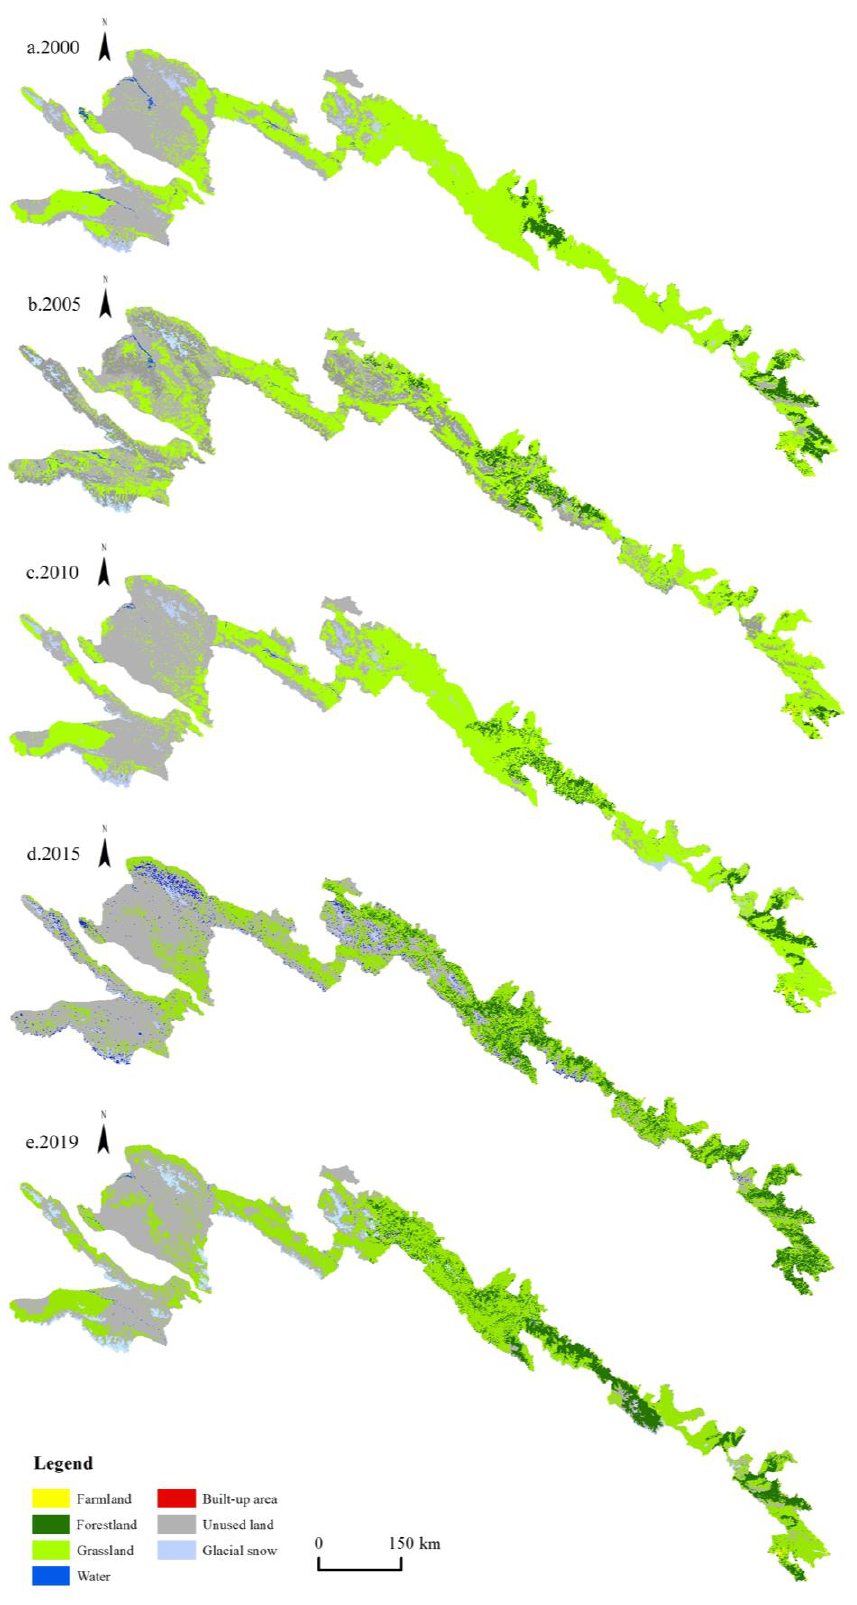
Figure 3. Land use status of Qilian Mountain National Park (Gansu Area) from 2000 to 2019. a-e represent the current status of land use in 2000, 2005, 2010, 2015, and 2019, respectively.